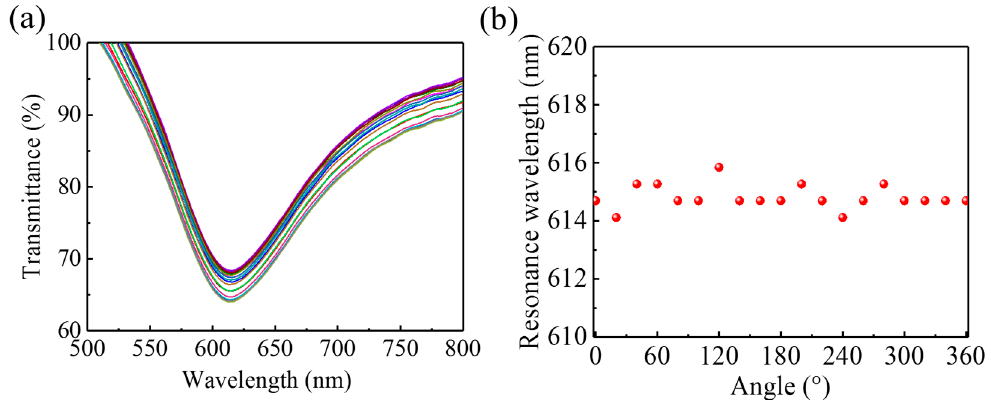
Figure 10. ( a ) Transmission spectra for different orientations and with no magnetic field, and ( b ) resonance wavelength as a function of rotation angle.